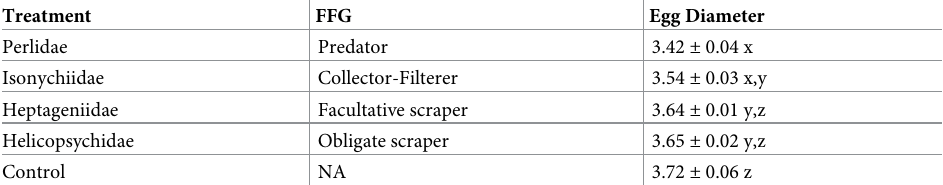
Table 1. Lake sturgeon mean ( ± SE) egg size (mm) by aquatic insect taxa characterized by different feeding special- izations (FS) treatments at Time 2 (4 da post fertilization).